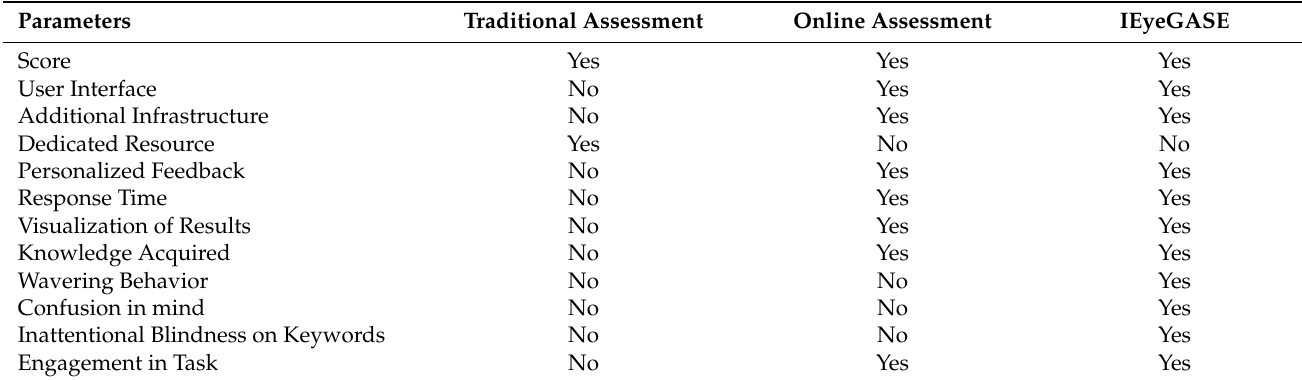
Table 5. Comparison between different assessment